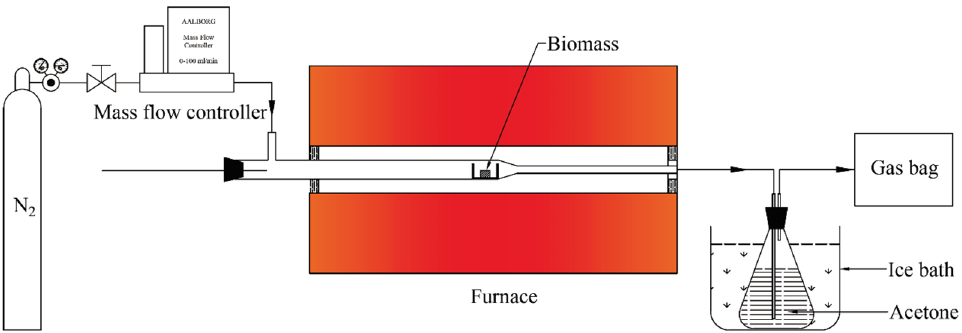
Figure 1. Schematic diagram of a fixed-bed biomass torrefaction experimental